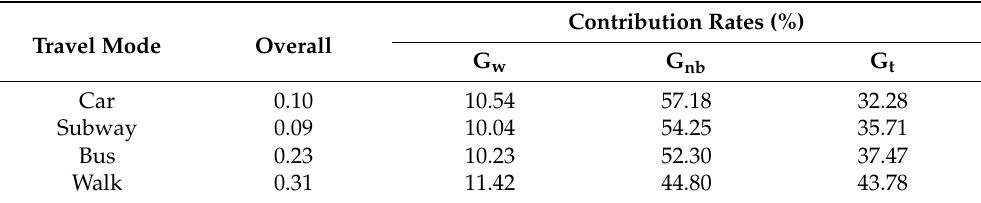
Table 2. The Dagum Gini coefficient and its decomposition results.